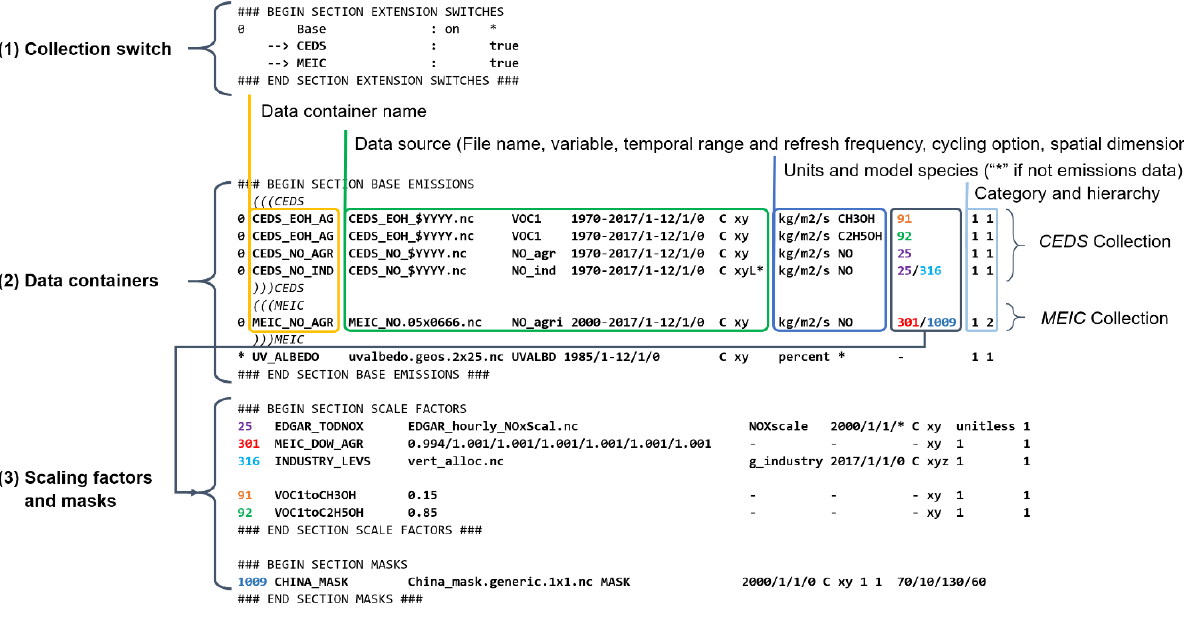
Figure 2. Sample HEMCO configuration file. The HEMCO configuration file is organized in three sections: (1) switches for “collections” of data containers, (2) data containers to be used in the model simulation optionally organized into “collections”, and (3) scaling and masking rules to be used. Entries are organized in a similar format, including a number and/or name, the data source (NetCDF file and variable name, numbers, or mathematical expressions), the temporal range and spatial dimensions, and their category and hierarchy (in the same category, data entries with higher hierarchy take precedence). For data containers, scaling factors and masks are applied by referencing the numbered scaling factor and mask entries (colored